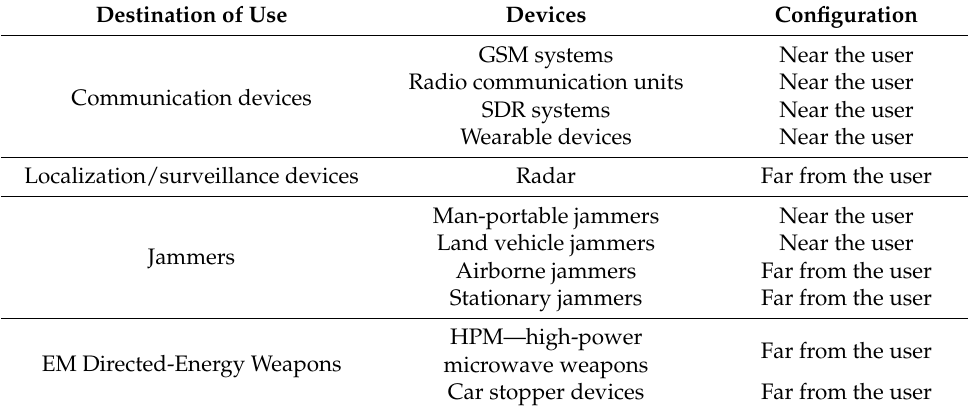
Table 6. Devices with their configuration.